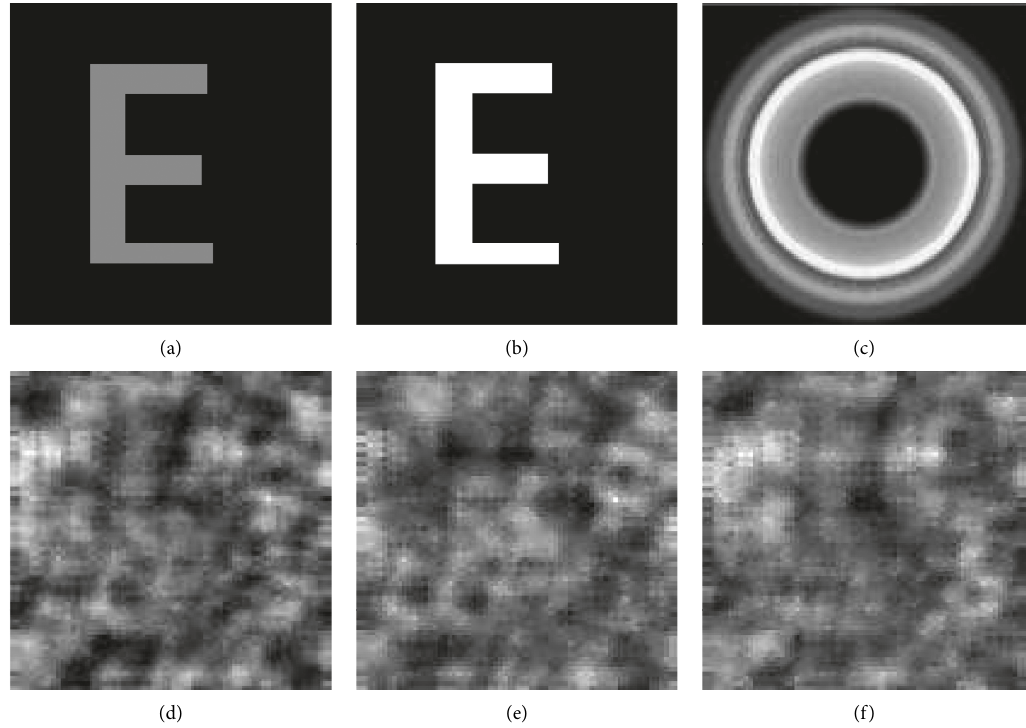
Figure 4: Simulation results based on the proposed encryption system: (a) intensity and (b) the corresponding phase of Figure 4(a), (c) one of the circular harmonic keys P m ( ρ hologram, and (f) recovered 􏽥 H − (